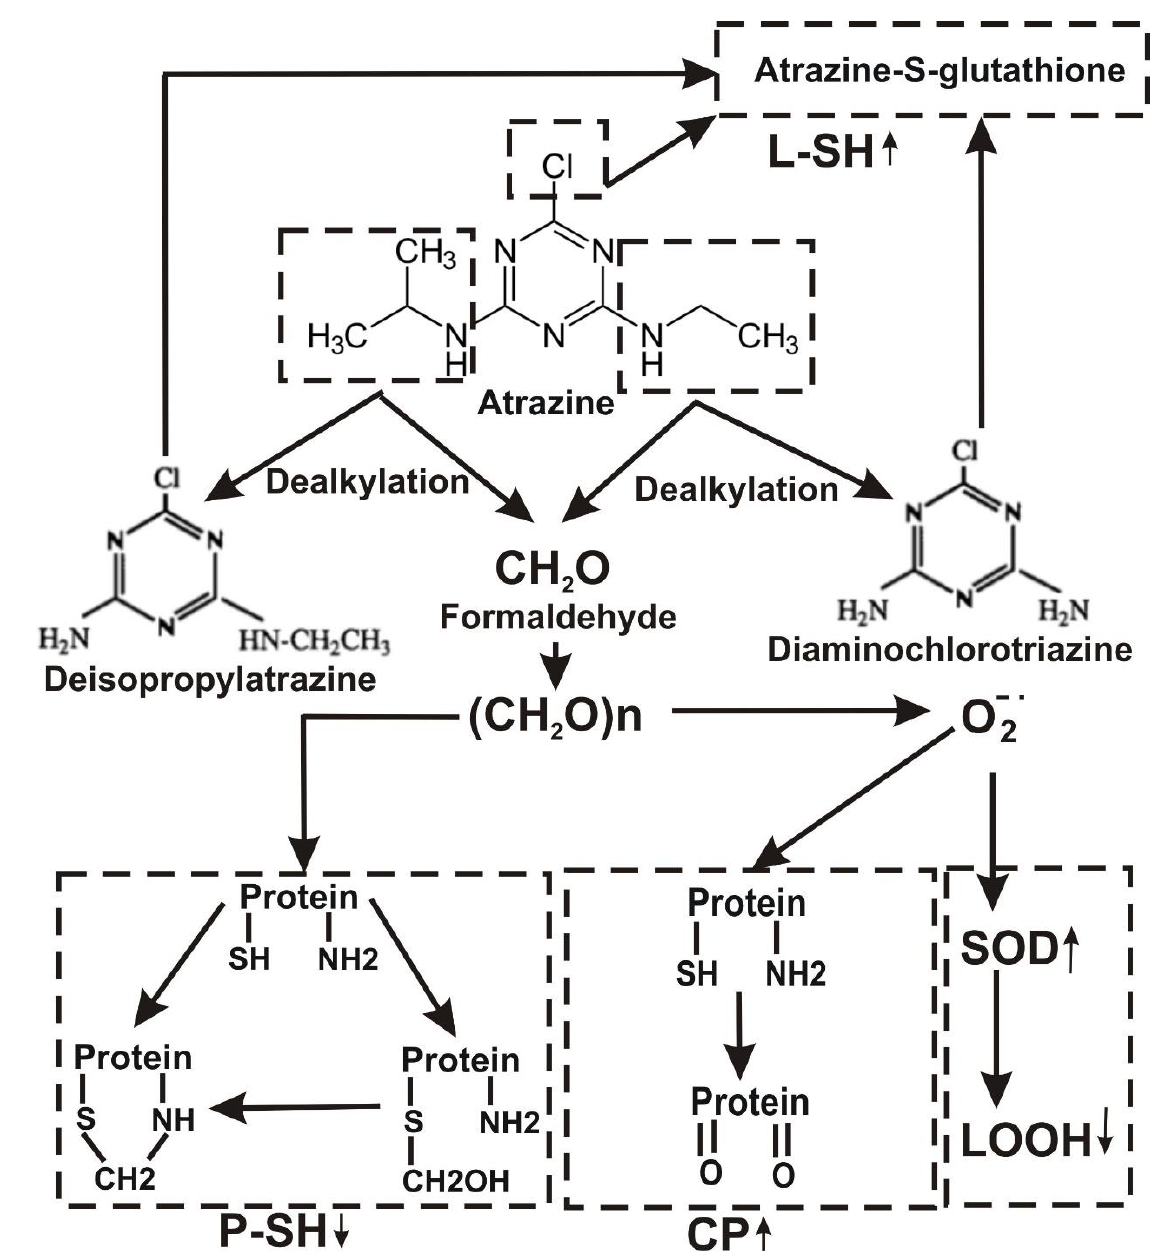
Figure 5: Hypothetical representation of mechanisms responsible for atrazine-induced stress in Daph- nia magna . CP, carbonyl protein; L-SH, low molecular mass thiols; P-SH, high molecular mass thiols; LOOH, lipid peroxides; SOD, superoxide